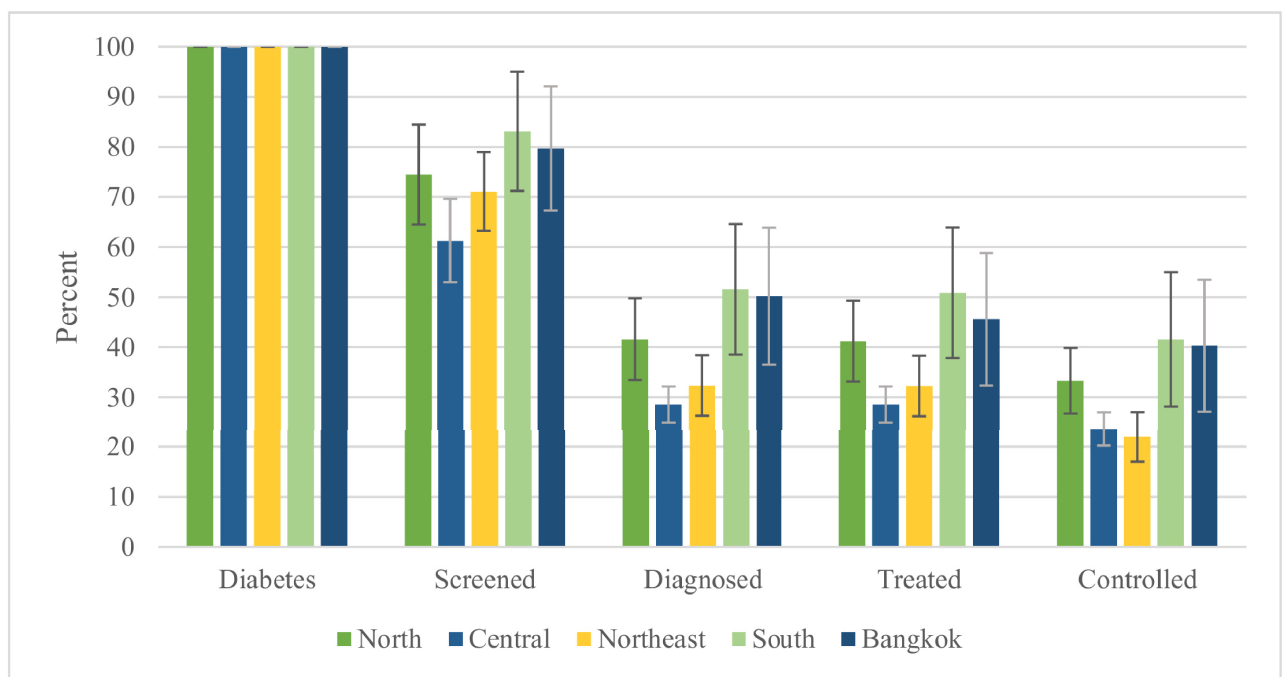
Fig 3. Regional diabetes care cascade, Thailand 2014. Point estimates are shown, with 95% confidence interval bars. Within different regions (North, Central, Northeast, South, Bangkok), people with diabetes had different rates of attrition across the care cascade. Among people with diabetes, the Northeast had the lowest rates of control (21.8%), while South had the highest rates of control (47.9%).